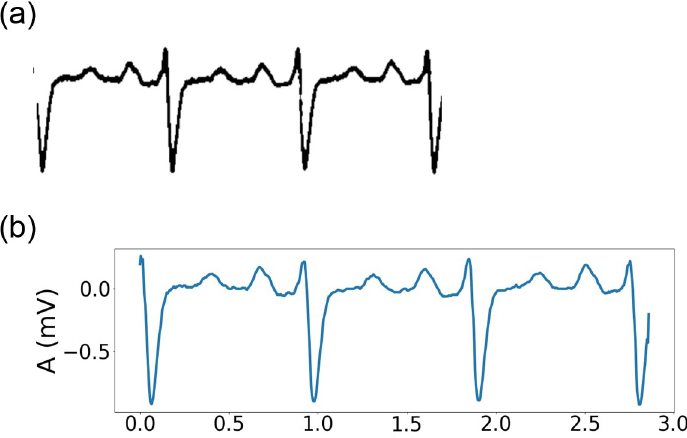
Fig 7. ( a ) Image of an ECG signal in lead II after preprocessing and ( b ) the resulting signal after image-signal